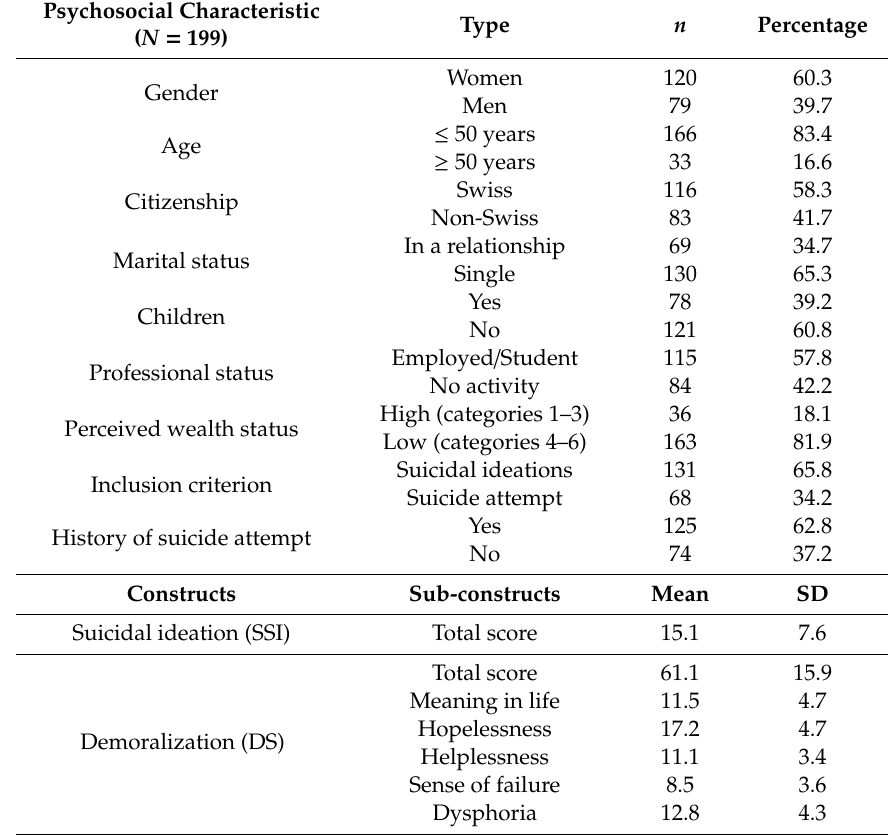
Table 1. Psychosocial characteristics and mean scores of scales measuring constructs /